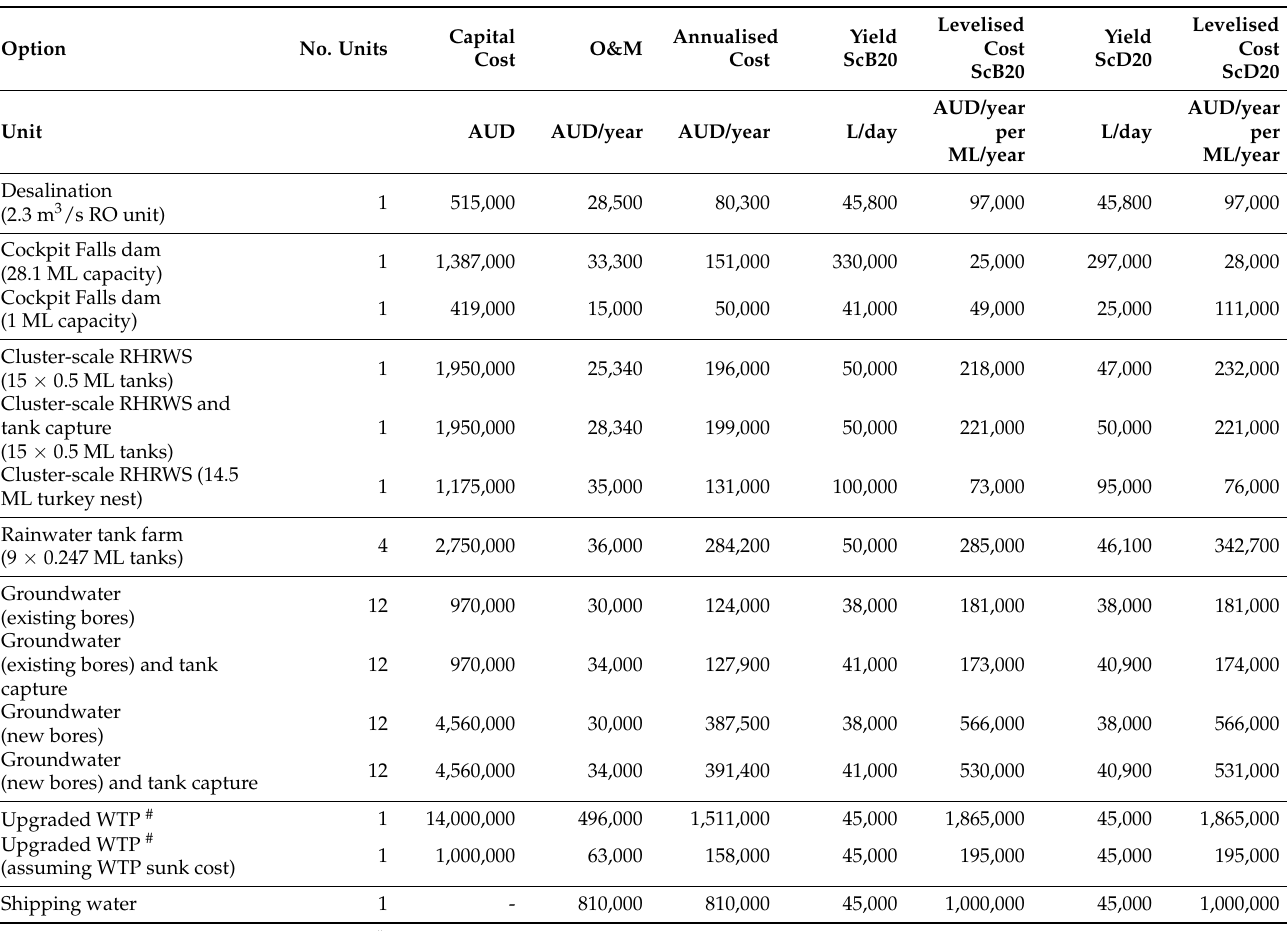
Table 6. Centralised management intervention options under Scenario B20. Cost estimates include contingency and have an estimated uncertainty of − 30% to +50%. Yield is the quantity of water that can be supplied at 100% reliability between 1 January and 31 March. Levelised cost is the annualised cost divided by the mean annual quantity of water supplied over the 50-year historical baseline and future climate sequence. Numbers are